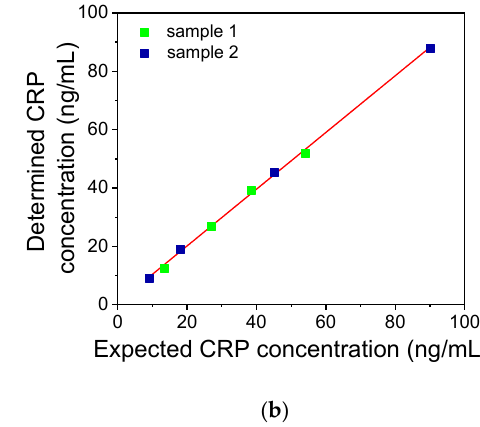
Table 1. Percent recovery values of exogenous added CRP to three human plasma samples.